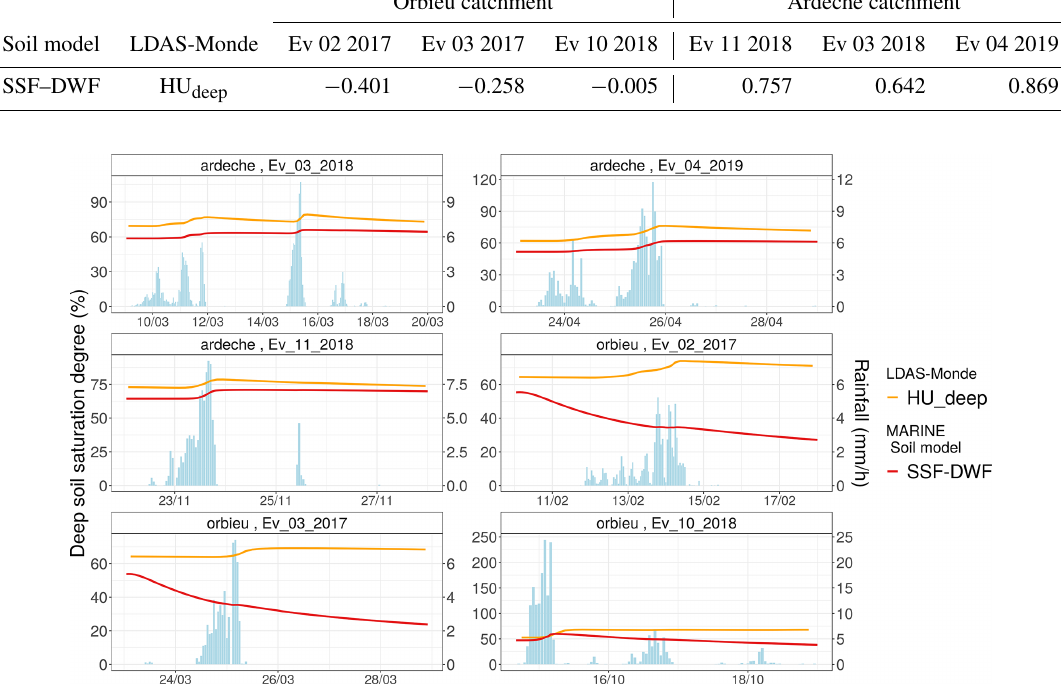
Figure 10. The SSD simulated for the deep layer with the SSF–DWF model, together with the LDAS-Monde HU deep time series, on average per